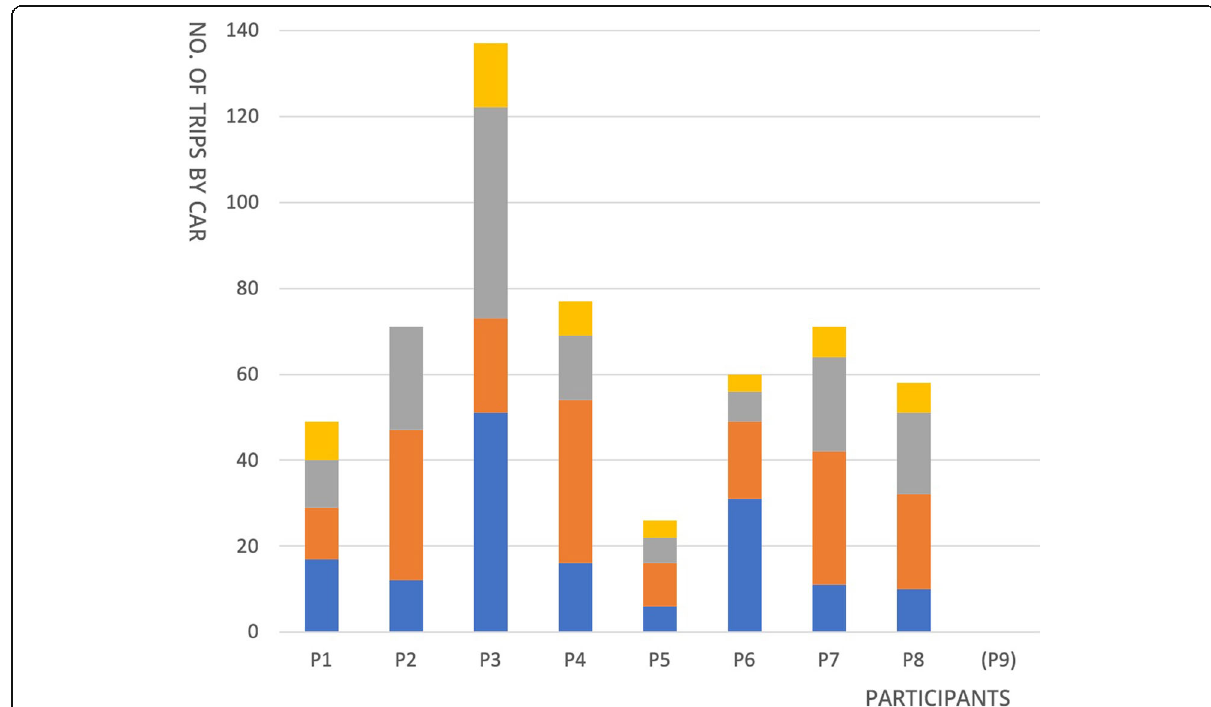
Fig. 4 Number of trips made by car in July